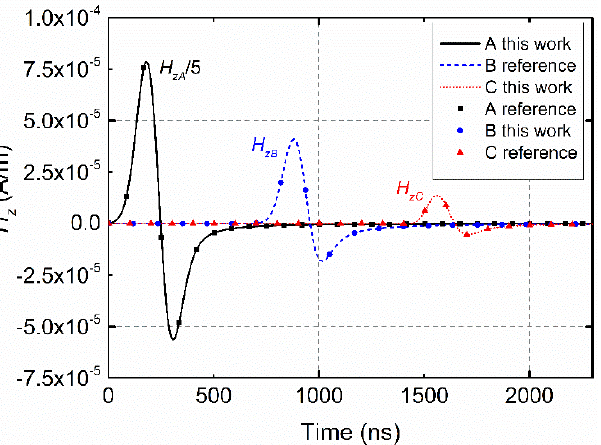
Figure 12. Magnetic field H z at points A, B, and C, with coordinates (300, 300, 1), (404, 300, 1), and (300, 404, 1). Principal axes are oriented along the Cartesian axes. The node size is 1 m for all directions. The field at point A was divided by a factor of five to better appreciate the three fields despite the attenuation at B and C.